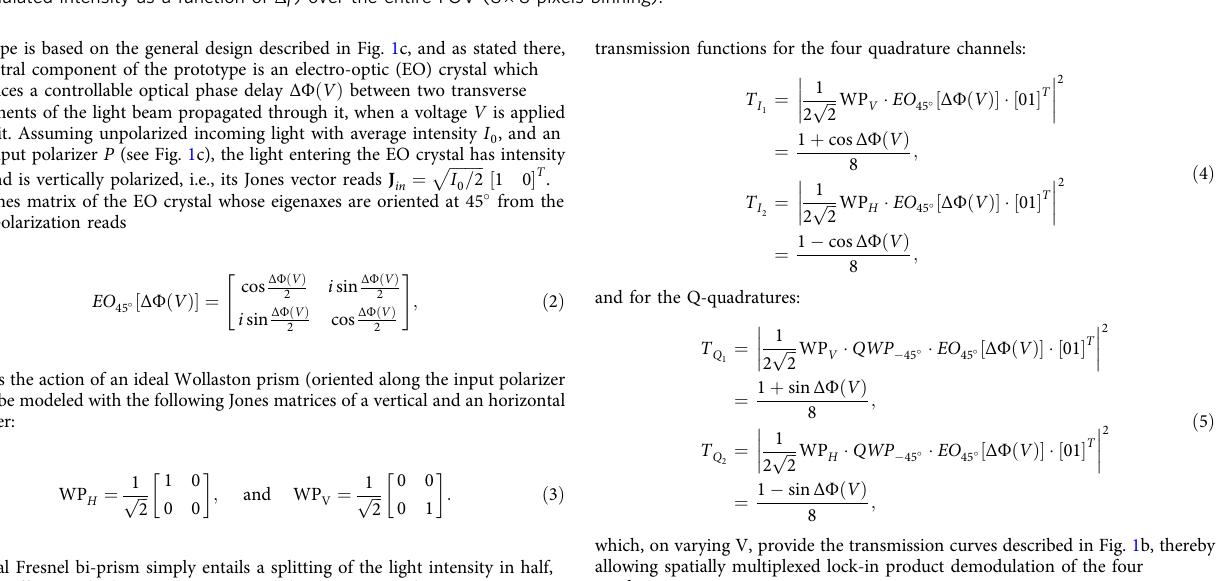
Fig. 3 Evaluation of frequency selectivity. a Demodulated amplitude averaged over 300 ´ 300 pixels plotted as a function of frequency detuning Δ f ¼ f (cid:3) f with steps of 0.12 Hz for f ¼ 5 kHz and 2 s exposure time (left); f ¼ 5 kHz and 250 ms exposure time (center); f ¼ 100 kHz and 2 s exposure d time (right). b FWHM of the demodulation ef fi ciency scales as the inverse exposure time. c Uniformity maps of the frequency selectivity (FWHM of